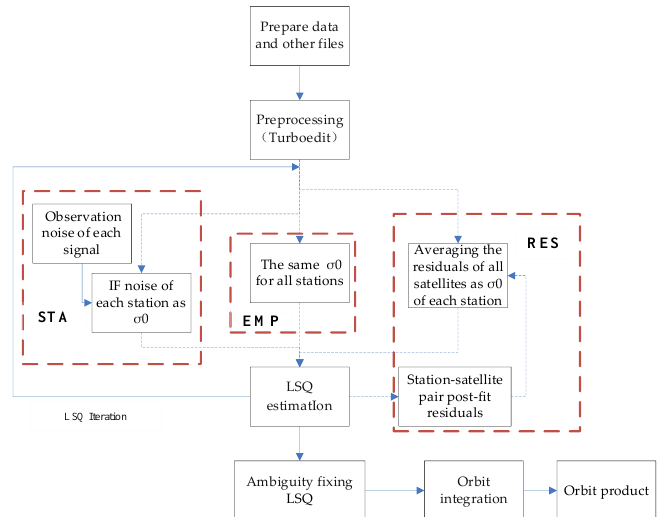
Figure 1. Process flow of the POD based on three stochastic models.